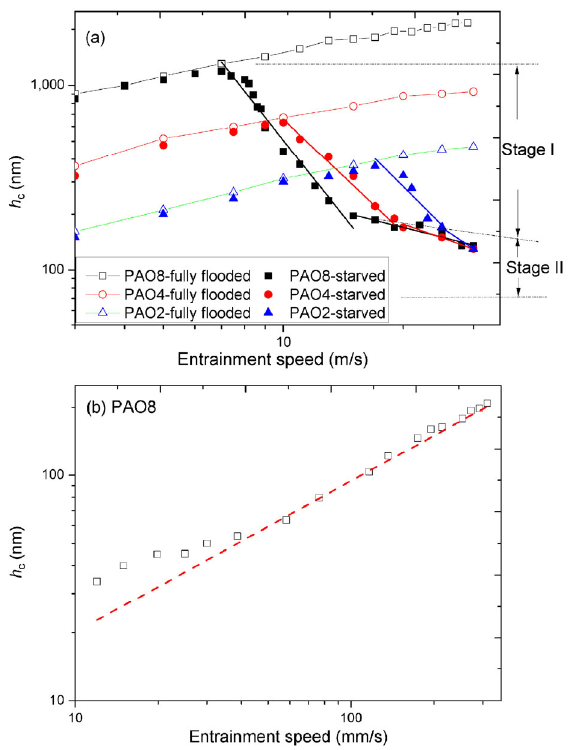
Fig. 1 Measurements of fully flooded and starved central film thickness for a range of speeds, pure rolling, p H = 431 MPa, t 0 = 25 ° C, oil supply: 4.25 mL/s for fully flooded lubrication and 0.85 mL/s for starved lubrication.